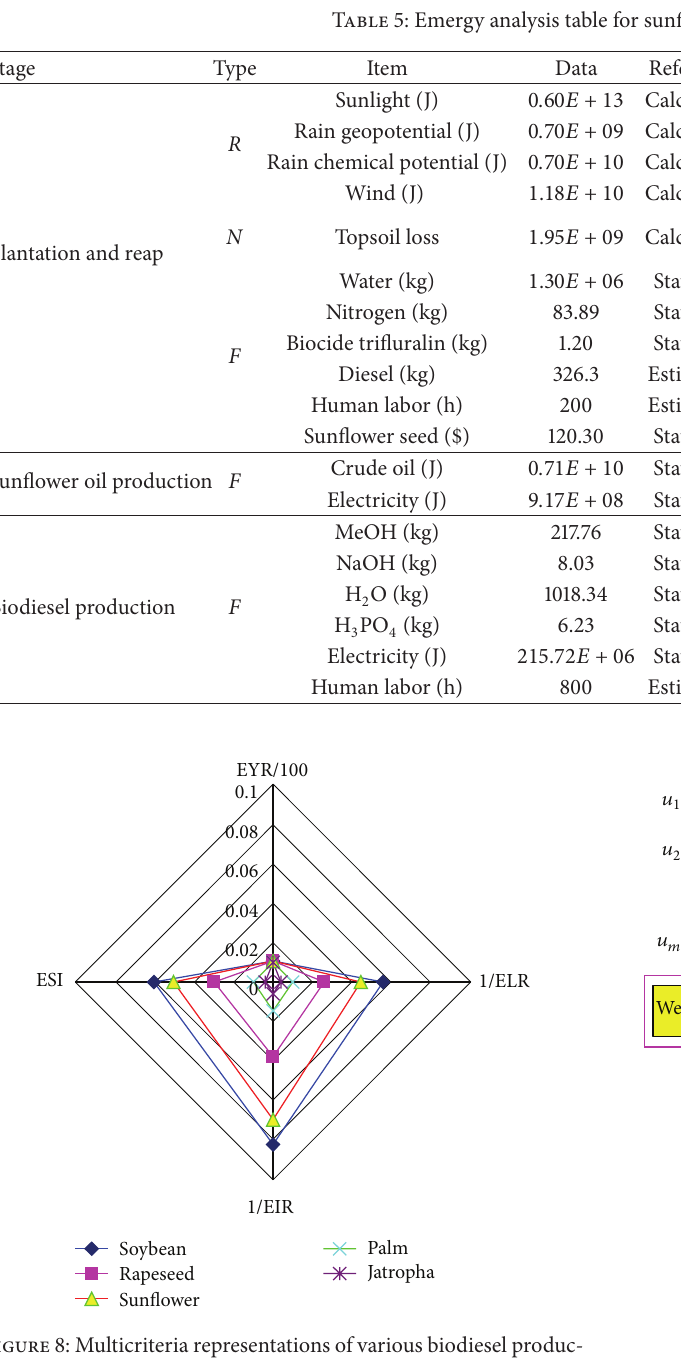
Figure 8: Multicriteria representations of various biodiesel produc- tion options.